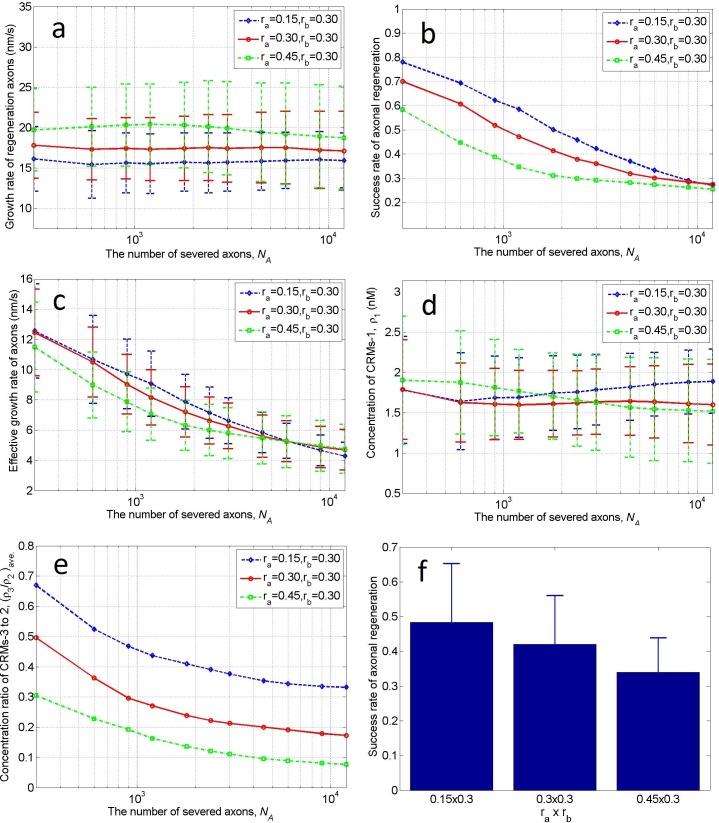
Influence of the number of severed axons on axonal regeneration.a) Growth rate of regenerating axons, b) success rate of axonal regeneration, c) effective growth rate, d) concentration of CRMs-1, and e) concentration ratio of CRMs-3 to CRMs-2, plotted as functions of log10
NA, where NA is the number of severed axons. The curves in each panel were obtained on scaffold No. 1 (0.15 × 0.3), No. 2 (0.3 × 0.3), and No. 3 (0.45 × 0.3), respectively. f) Longitudinal coordinates in panel b averaged over the number of horizontal coordinates on scaffolds No. 1, No. 2, and No. 3 (left to right). Error bars indicate the standard deviations.